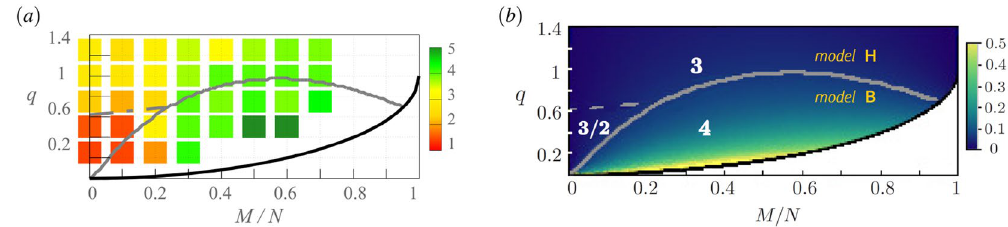
Figure 7. The values of dynamical exponent z d versus M / N and q revealed in the antiferromagnetic condensate, marked by color in ( a ) while in ( b ) by white numbers. ( a ) The values of colored boxes are numerically fitted results from Fig. 4 and Fig. 6, provided that below the solid gray line logarithmic correction to the scaling law is taken into account. ( b ) When the occupation N 1 / N (shown by color) is substantial or marginal, the B or − H model’s scaling is realized, respectively. The solid gray line marks the border between the H and B models 0.025 . The gray dashed line is the transition point q estimated by the condition N 1 / N th where the two = − different scaling exponents apply for the model H. The top edge of the white area, which is restricted by relation 1 1 ( M / N ) 2 , determines where the critical transition between 2 C and 2 C ρ 0 phases takes q c = − − + (cid:31)